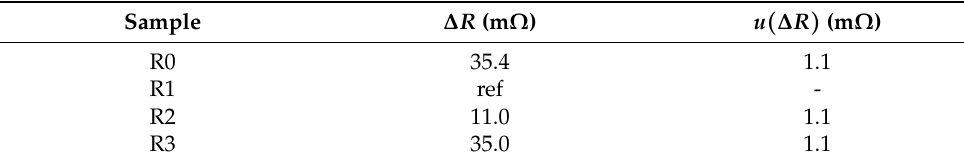
Table 2. ∆ R s measurement